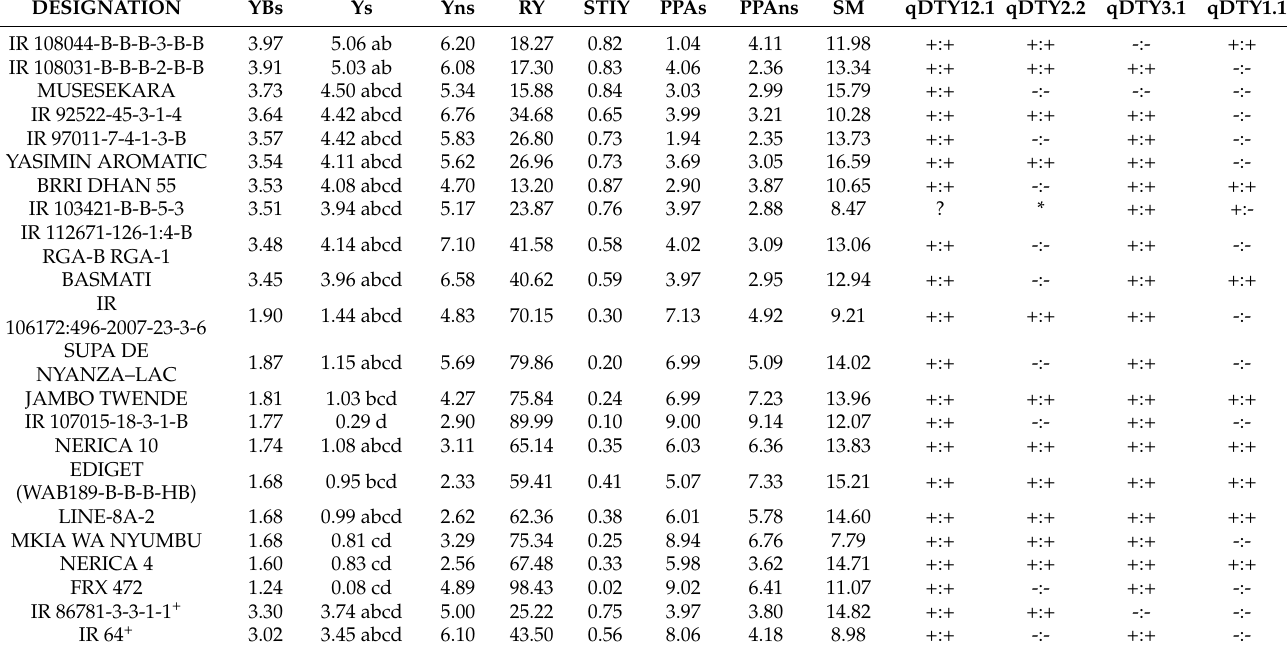
Table 3. Summary of means and genotypic information for the ten best and ten worst genotypes and checks based on yield BLUPs under drought